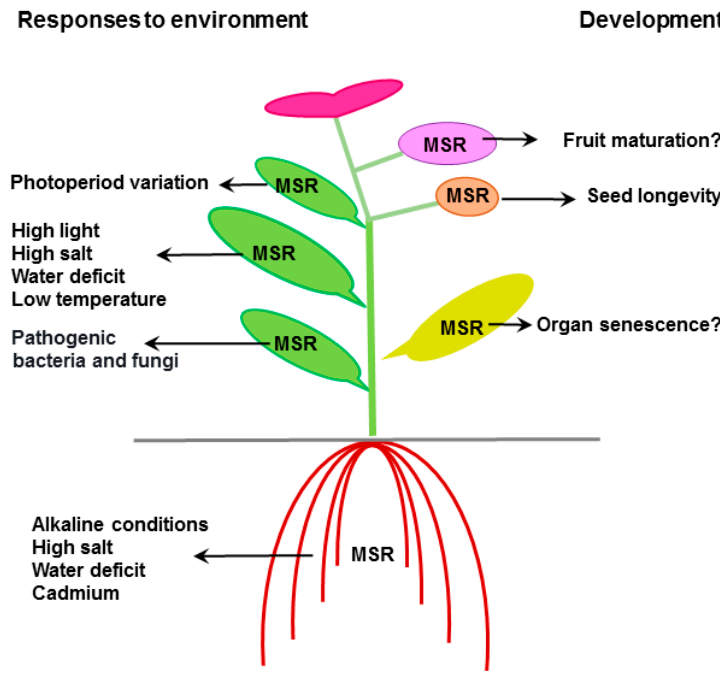
Figure 3. Physiological functions of plant MSRs. The functions of MSRs in the responses to high light, high salt, high carbonate, water deficit, low temperature, cadmium and in photoperiod adaptation was shown in Arabidopsis [50,52,76,105,107,112,113] rice, [55,57,114] or Glycine soja [60]. The participation in responses to biotic constraints was reported in Arabidopsis [86], pepper, or tomato [56] the involvement in seed ageing in Arabidopsis and Medicago truncatula [68]. The presumed role in organ senescence and fruit maturation is based on expression patterns and identification of possible partners in Aarabidopsis, strawberry, litchi, and banana